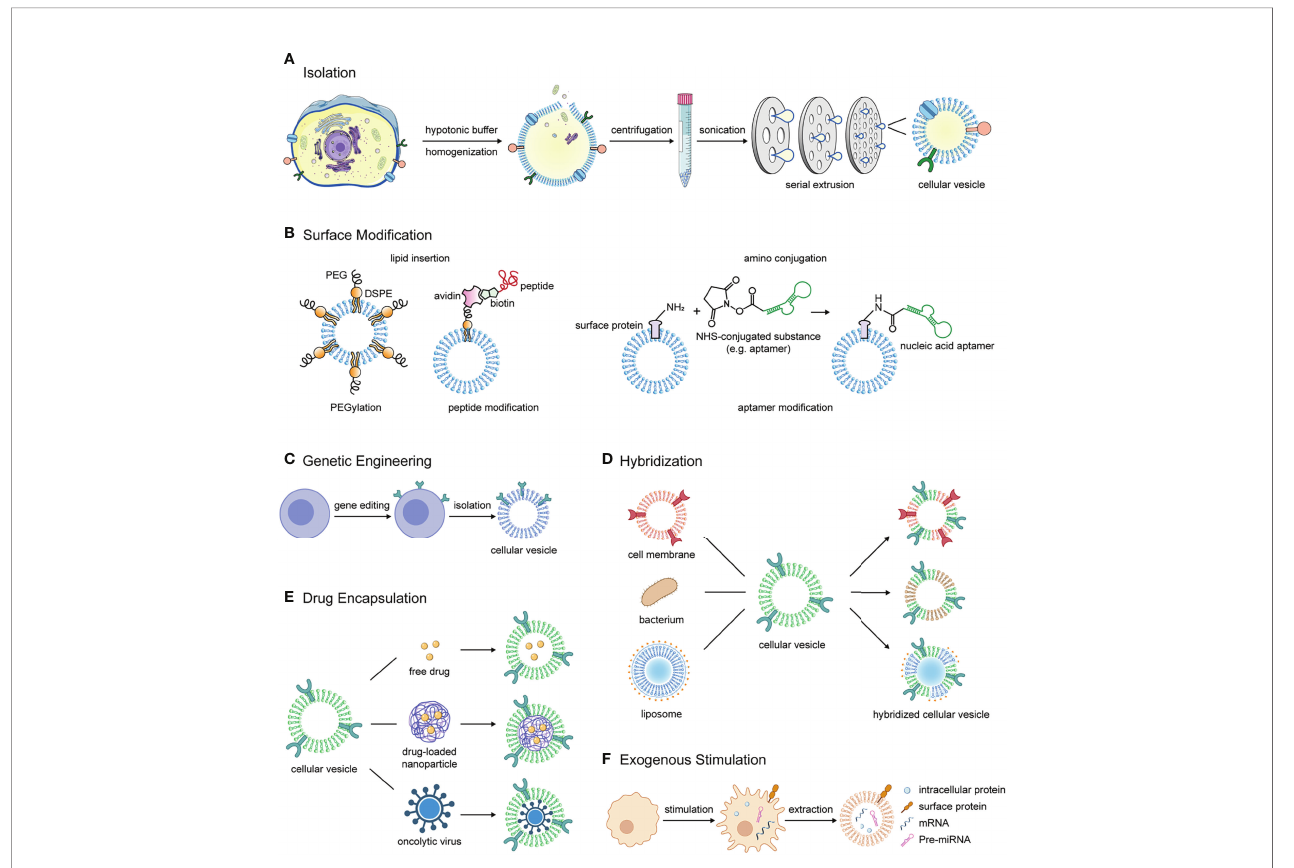
FIGURE 1 | The manufacturing process, modi fi cation methods, and application strategies of cellular vesicles in combinational immunotherapy of cancer. (A) The process of isolating cell membrane-derived vesicles from parental cells. (B) Methods for modifying substances such as polyethylene glycol, tumor targeting peptide and nucleic acid aptamer on the surface of cellular vesicles. (C) Cellular vesicles inherit antitumor proteins that the parental cells overexpress through gene editing. (D) Cellular vesicles are hybridized with different materials such as cell membranes from other sources, bacterial membranes and liposomes to obtain multiple components and functions for cancer immunotherapy. (E) Free drugs, drug-loaded nanoparticles or oncolytic viruses are encapsulated in cellular vesicles for delivery to the tumor lesions to activate antitumor immunity. (F) In response to exogenous stimulation, immune cells produce a variety of tumor growth inhibitors including surface markers, intracellular proteins, mRNA for pro-in fl ammatory cytokines, and certain miRNAs, which can be retained in cellular